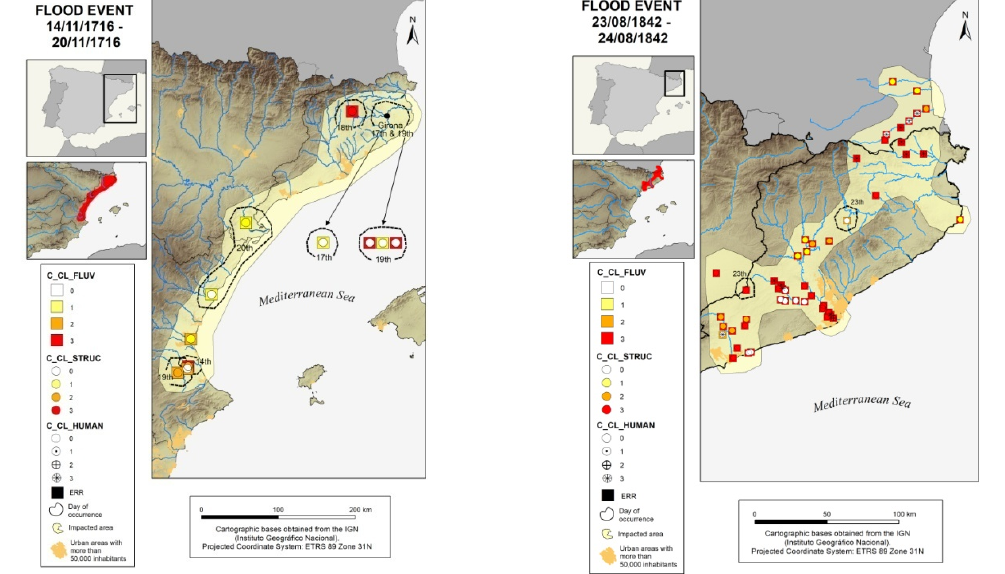
Figure 3. ( Left ): Representation of cases for the flood event of 14 to 20 November 1716. ( Right ): Representation of cases for the flood event of 23 and 24 August 1842. C_CL_FLUV: Variable 1. Hydraulic behaviour of the river flood. C_CL_STRUC: Variable 2. Flood impact on structural elements. C_CL_HUMAN: Variable 3. Social/personal vulnerability to the flood. ERR: Erroneous or spurious cases. Blue line: Basic fluvial system. Black line: Spanish Hydrographic Demarcations. Urban areas: Population according to 2022 demographic